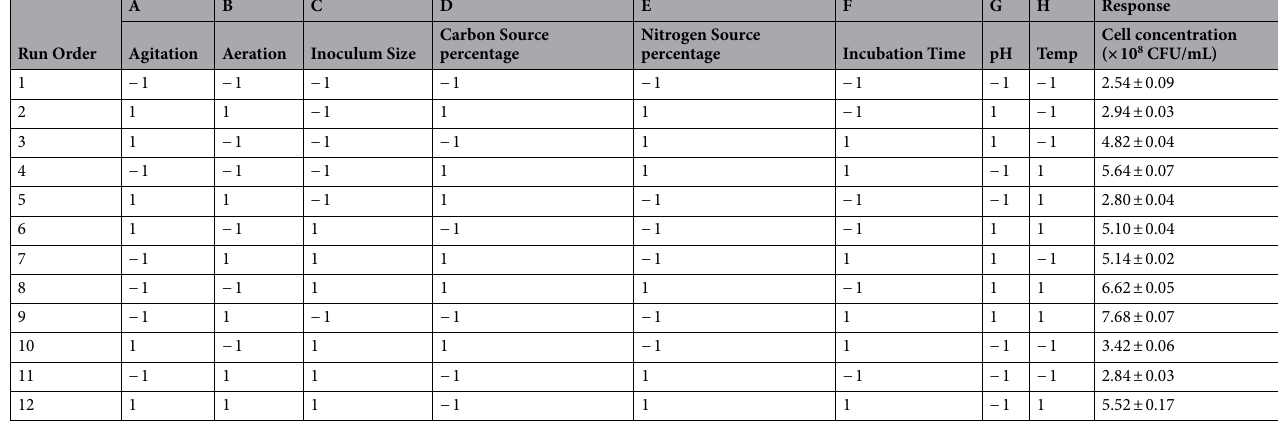
Table 2. PBD experimental runs for screening the significant independent factors affecting the growth of CW-S. Within columns, CFU ± SD values (n = 3).